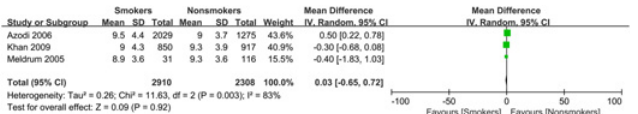
Fig 6. Forest plot of the association between smoking and the length of hospital stay after total hip